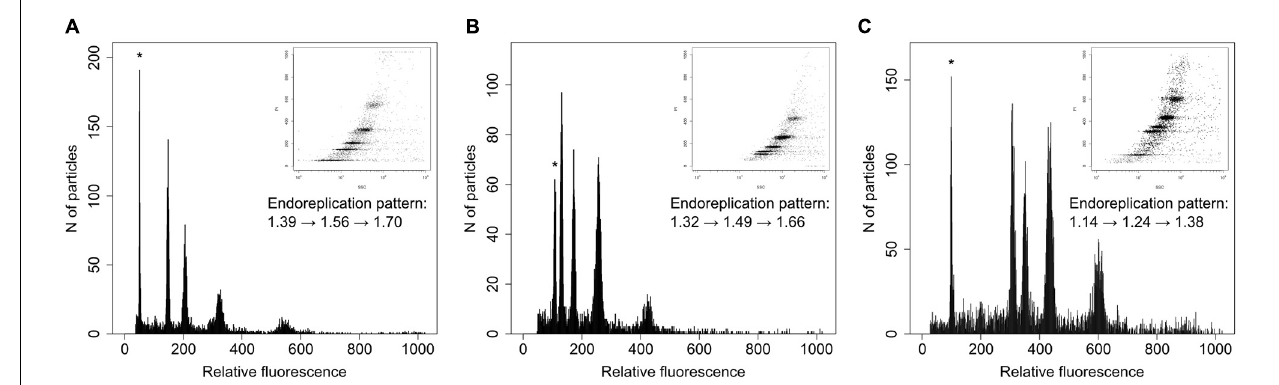
FIGURE 3 | Example histograms of three taxa of Neotinea displaying different genome size and pattern of endoreplication. (A) N. maculata from Cyprus, (B) N. ustulata var. ustulata from Slovakia, and (C) N. lactea from Crete. The peaks of the internal standards ( Solanum pseudocapsicum – A , Pisum sativum – B,C ) are labeled by asterisks. Embedded images correspond to 2D plots of side scatter and fluorescence intensity of nuclei stained with propidium iodide. The pattern of endoreplication is given by a formula showing a genome size increase of four subsequent peaks of Neotinea